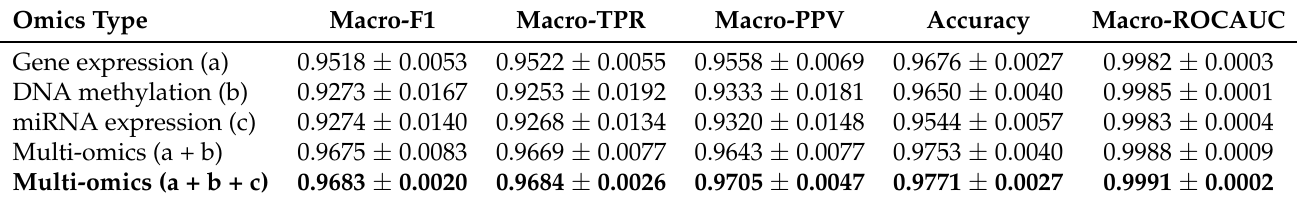
Table 4. The performance of tumour type classification on the GDC multi-omics dataset with different omics type